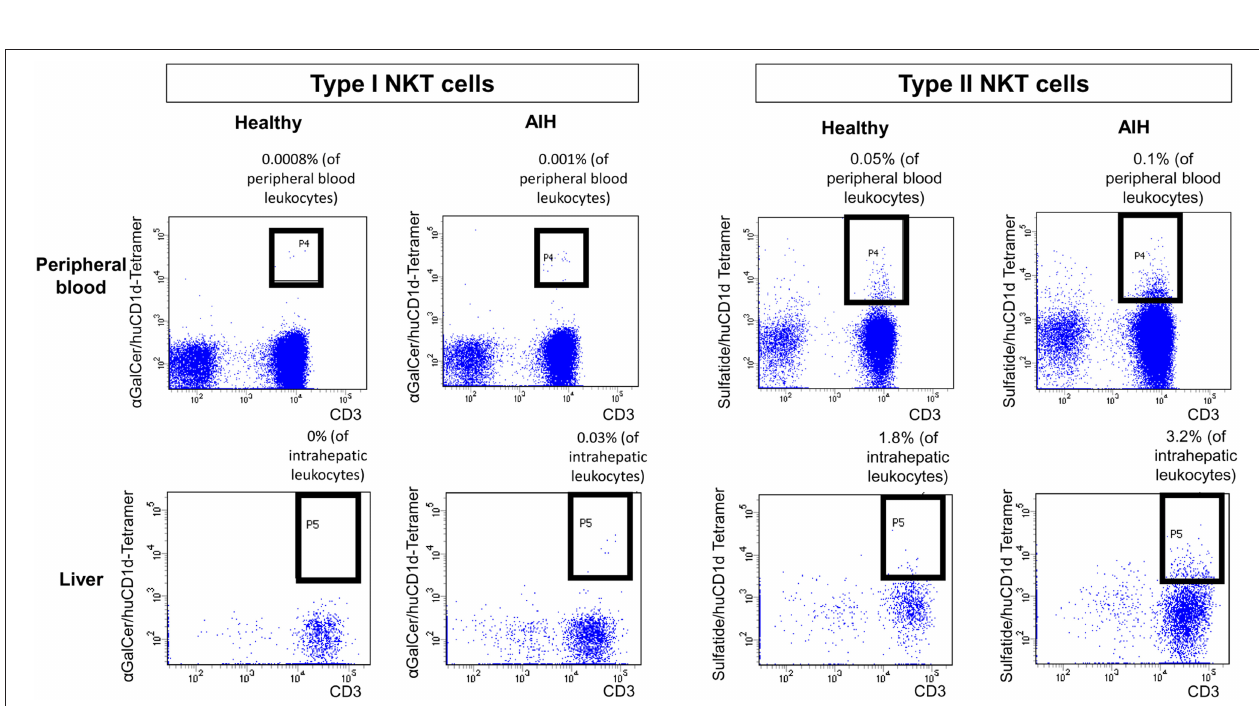
FIGURE 1 | Exemplary CD1d tetramer stainings. Mock-loaded human CD1d tetramers served as negative control staining for lipid-loaded human CD1d tetramers. An exemplary peripheral blood (upper row) and intrahepatic (lower row) flow cytometric staining with mock-loaded human CD1d tetramer (left) and sulfatide-loaded human CD1d tetramer (right) from an AIH patient is shown.